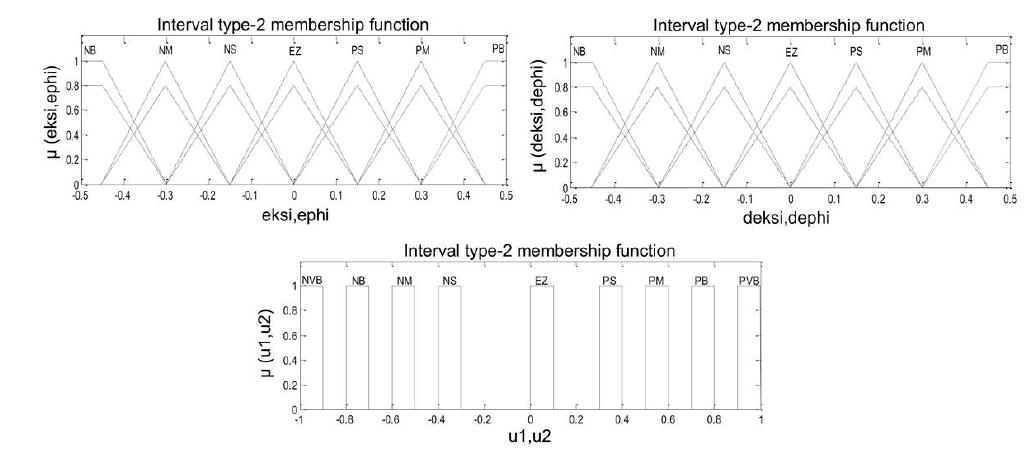
Figure 7. Type-2 fuzzy membership functions.